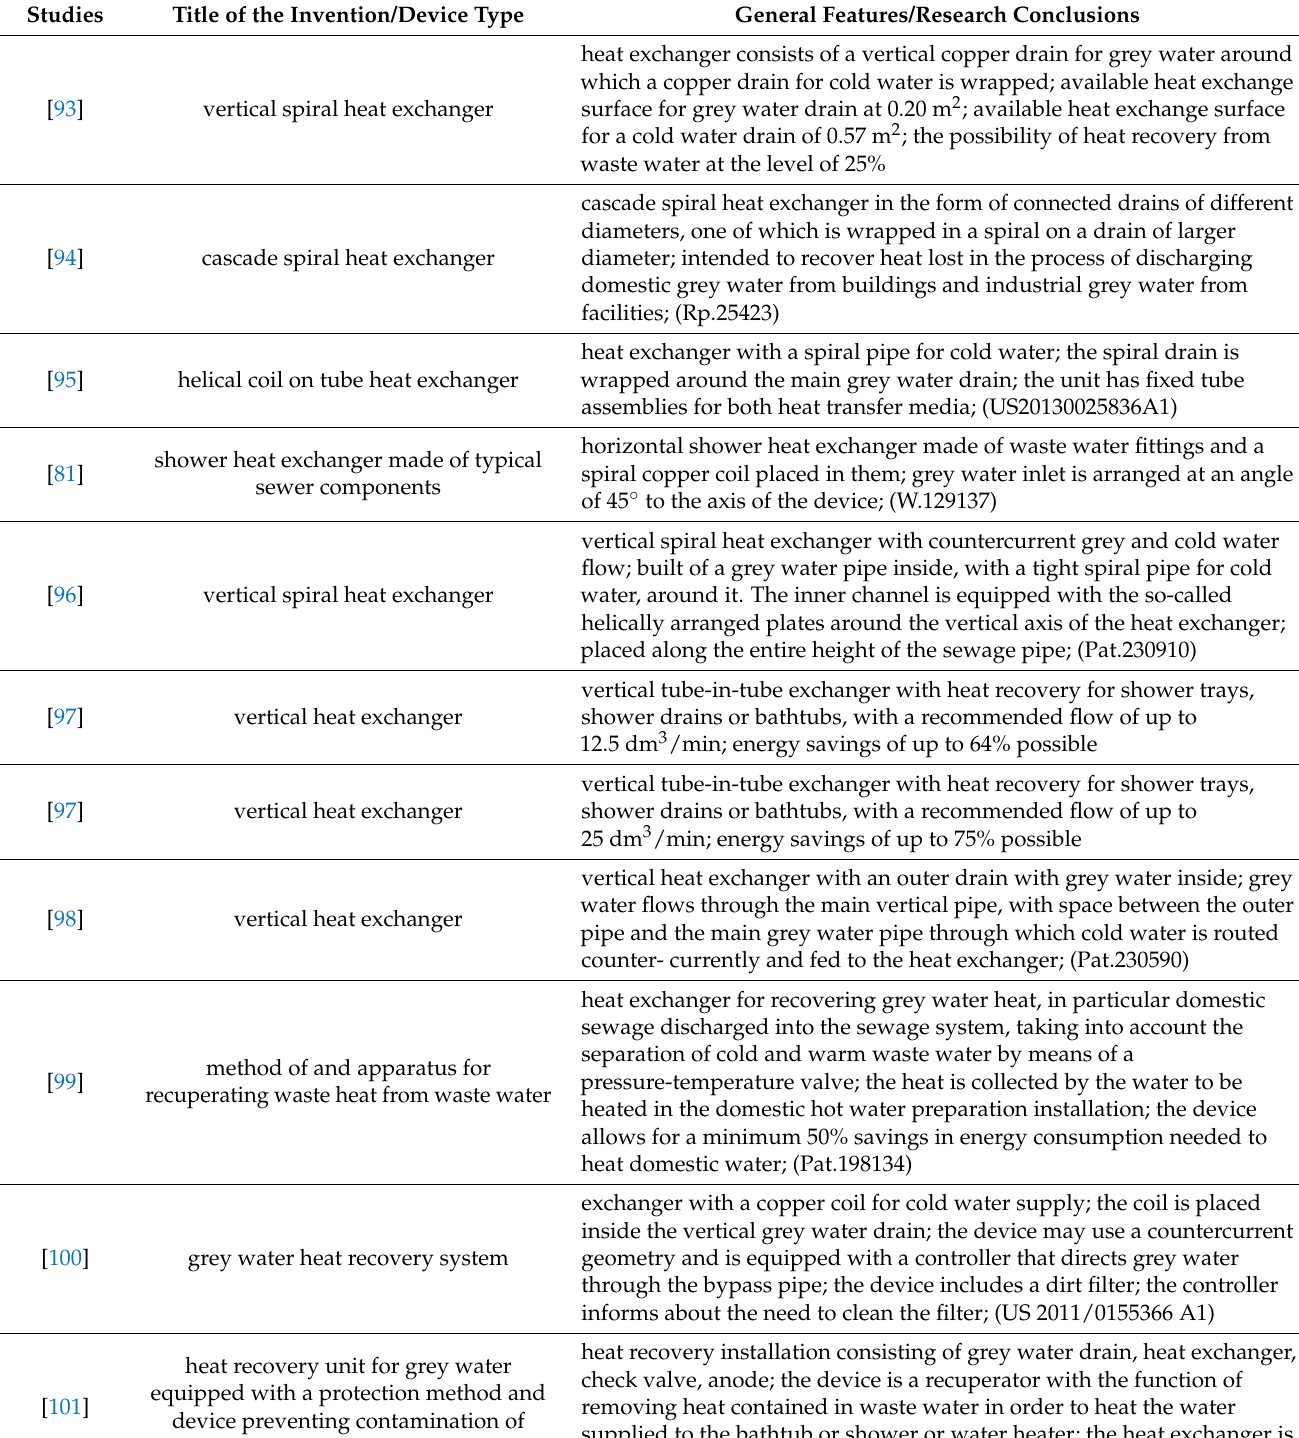
Table 2. Summary of the analyzed references regarding vertical